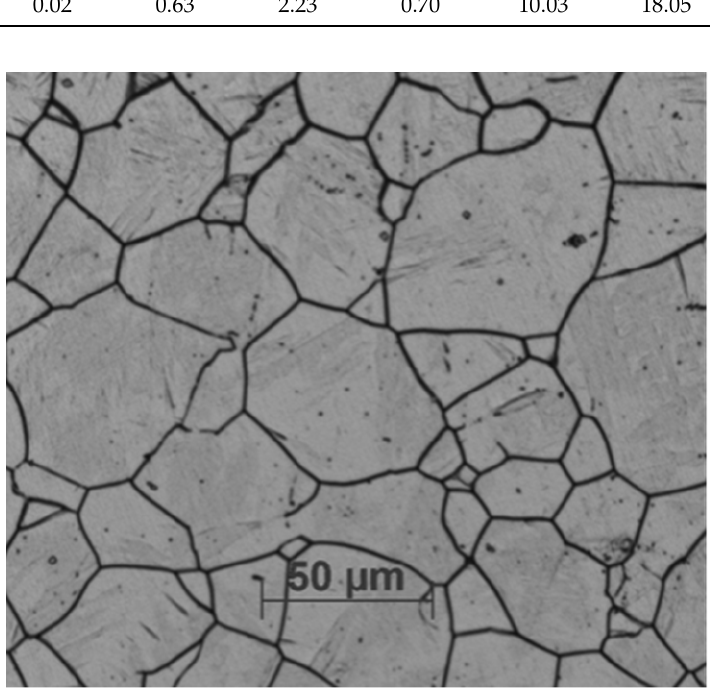
Figure 1. The microstructure of 321 austenitic stainless steel.